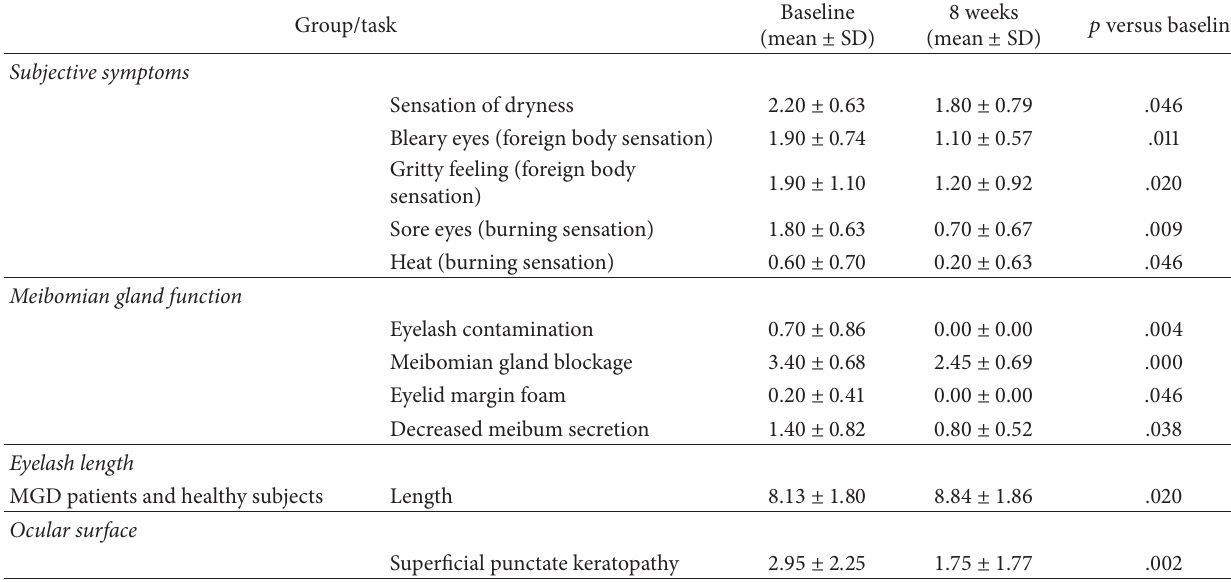
Table 7: Comparison of symptoms, meibomian gland function, eyelash length, and ocular surface according to treatment group (we listed the items with 𝑝 < .05